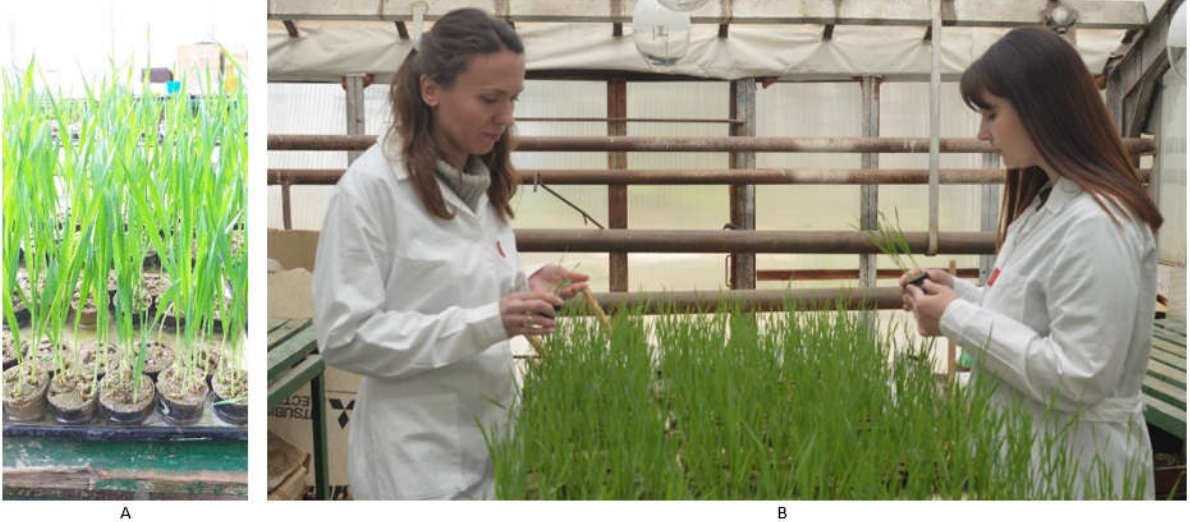
Figure 4. Accounting for the development of barley leaf rust in the greenhouse: ( A ) barley seedlings infected with monopustular isolates of P. hordei (orig.); ( B ) Accounting for the types of reactions of seedlings of barley differentiator varieties to infection with P. hordei monopustular isolates (orig.).